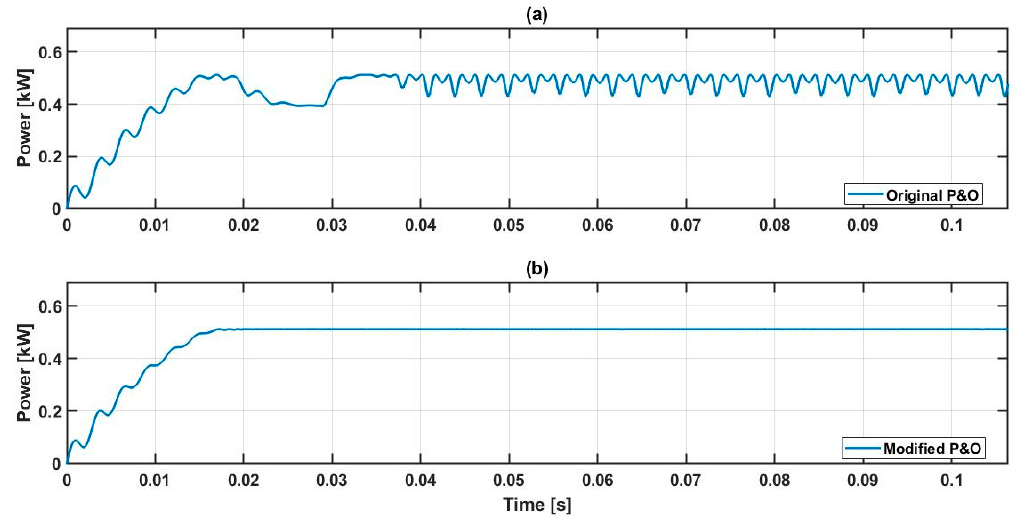
Figure 13. High-power PV system response time and perturbations: ( a ) original P&O algorithm and ( b ) modified P&O algorithm.